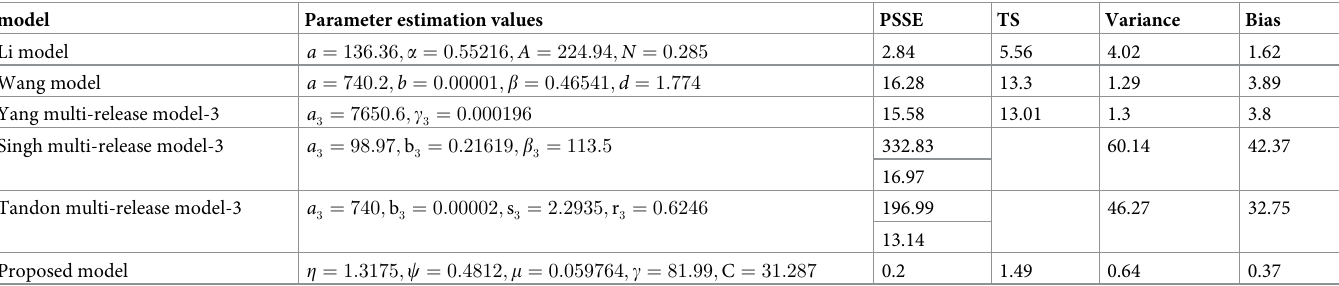
Table 7. Comparison of the predictive performance of models using 80% of fault data (DS2-3).